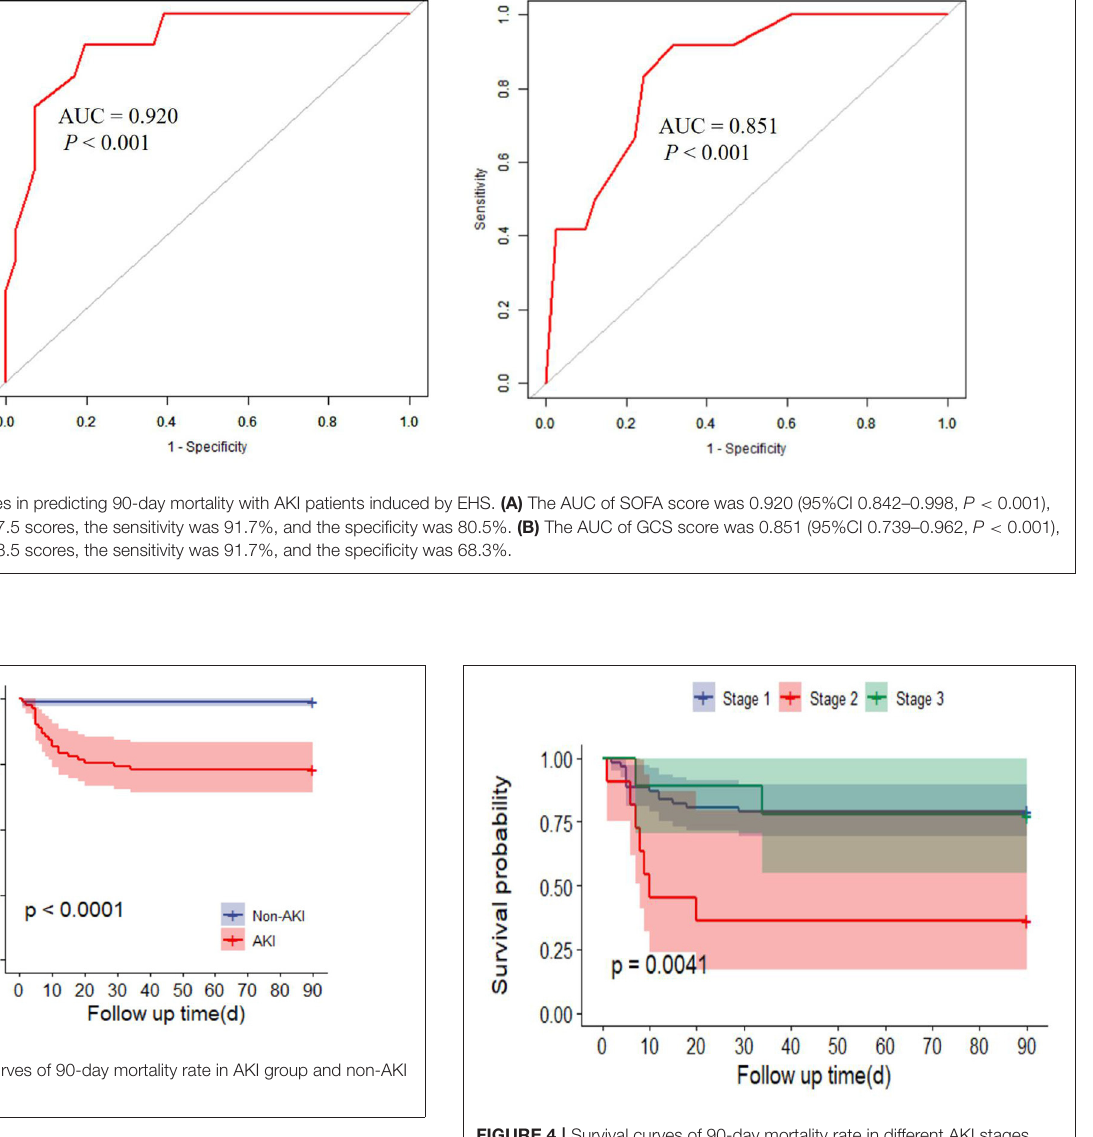
FIGURE 4 | Survival curves of 90-day mortality rate in different AKI